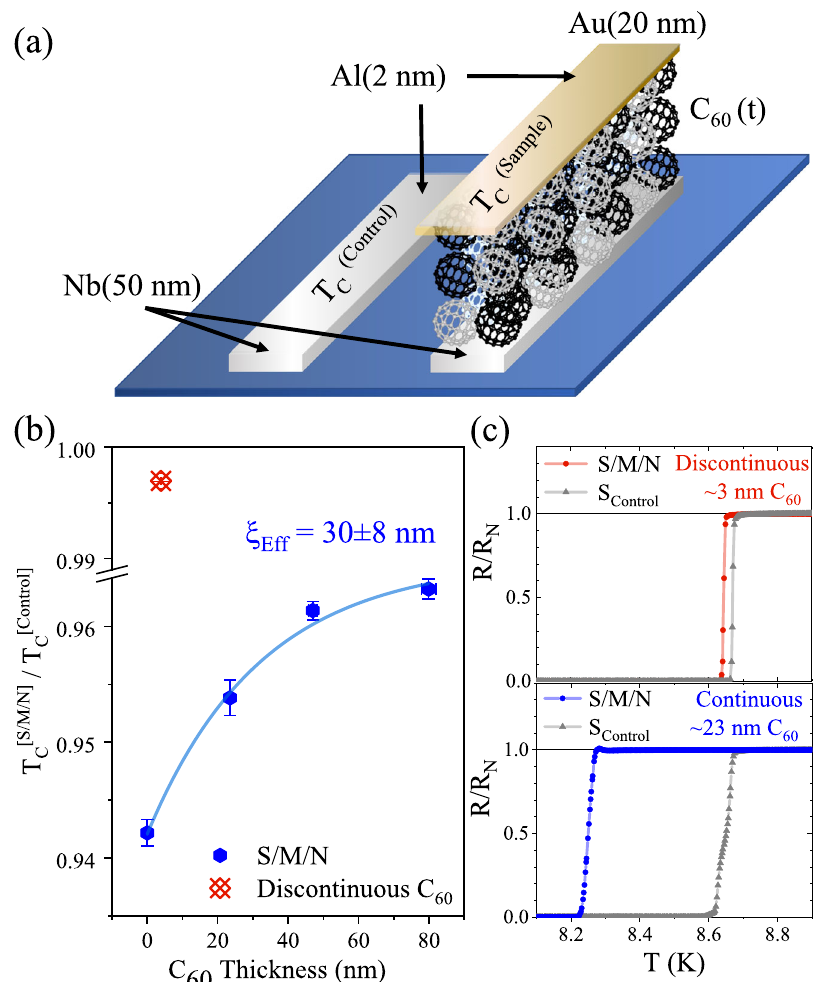
Fig. 2 Low-temperature characterisation of hybrid superconducting/molecular/metal heterostructures. a A schematic showing the fabricated sample which is grown alongside a control Nb fi lm. b The dependence upon the superconducting transition temperature ( T c ) suppression with C 60 thickness for Nb (50 nm)/C 60 (t)/Au(20 nm)/Al(2 nm) stacks for continuous (blue symbols) and discontinuous (red symbols) C 60 fi lms. The modi fi cation of the superconducting gap energy via the inverse proximity effect is greatest for the sample without C 60 . As a fullerene barrier layer is introduced, and its thickness increased, the T c never fully recovers to its pristine value. Therefore, there is a leakage of Cooper pair states into the C 60 and through to the Au, where an effective length scale for the propagation of Cooper pairs is ξ Eff = 30 ± 8 nm. A y -axis line-break allows the data point obtained for the sample with a discontinuous island-like C 60 barrier to be shown. Error bars are uncertainties in the critical temperature measurement. For each point, the T c suppression is obtained via low-temperature transport measurements, such as those shown in ( c ; grey symbols are for the control magnetic hardening (Fig. 3b) 23,25,38 . The sample with the Cu/C 60 interface has a moment per area of m = 27±1 μ emu cm − 2 , which equates to a volume magnetisation of 90 ± 3 emu cm − 3 , assuming that the magnetic order is localised to the Cu. The sample without a Cu/C 60 interface has a moment of m = 2 ± 1 μ emu cm − 2 , consistent with a typical instrumental background.